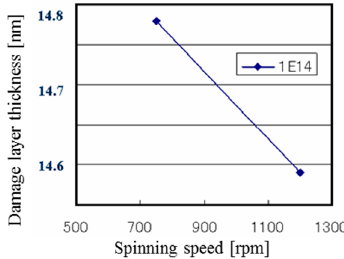
Figure 13. Damage layer thickness dependence on disk spinning speed [22]. Batch type: GSD-HE (SMIT); Ion: BF 2 ; Energy: 20 keV; Dose: 1 × 10 14 cm − 2 . Although amorphous layer was not generated by this experiment, a damage layer with different optical index was observed by a spectroscopic ellipsometer. The damage layer thickness indicates thickness of the damage layer.